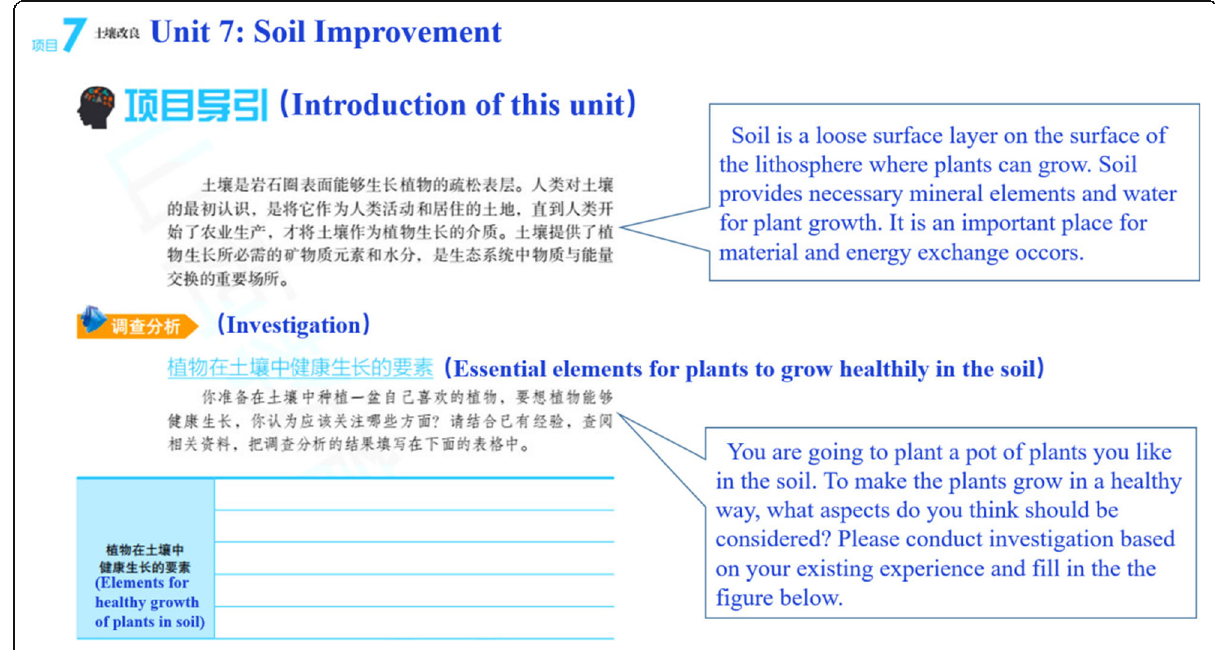
Fig. 1 Screenshots of the PBTETC